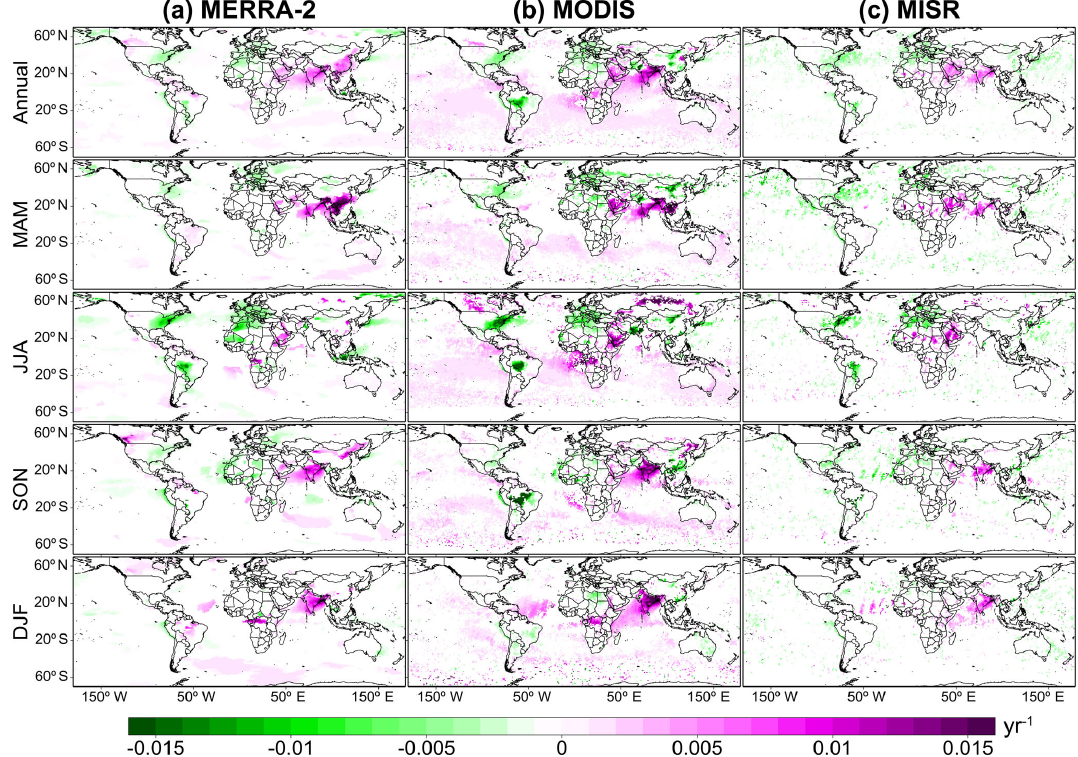
Figure 7. Spatial distributions of annual and seasonal trends in AOD calculated from the time series value of the deseasonalized monthly anomaly from (a) MERRA-2, (b) MODIS/Terra, and (c) MISR between 2001 and 2016. Only trend values with statistical significance at the 95% confidence level are